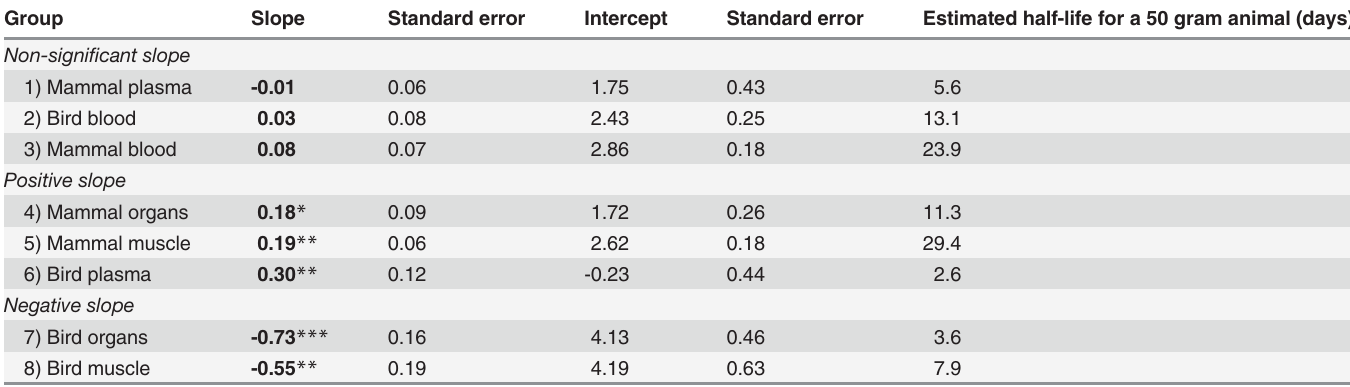
Table 4. Group (tissue-taxa combination) intercepts and slopes (including standard errors) for body mass — half-life relationships for endothermic groups.